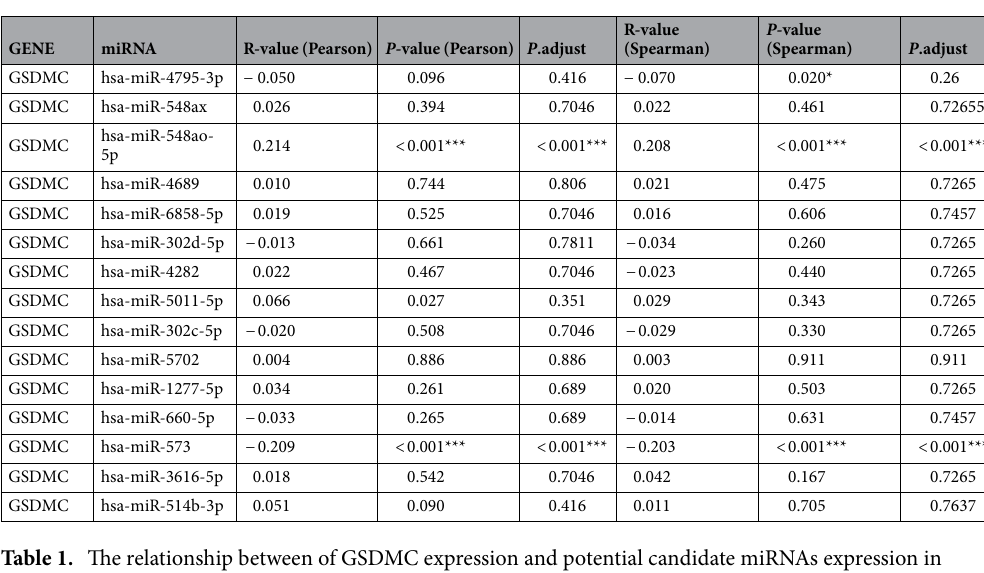
Table 1. The relationship between of GSDMC expression and potential candidate miRNAs expression in BRCA. * P < 0.05 (5e-02); ** P < 0.01 (1e−02); *** P < 0.001 (1e−03).